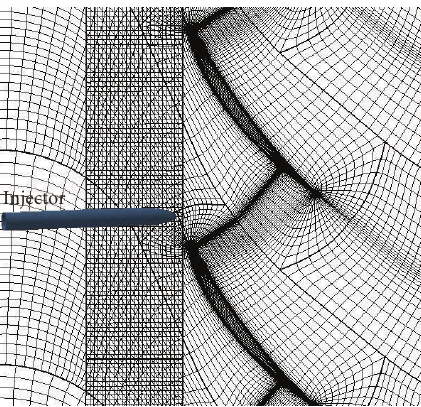
Figure 2: Circumferential transducer locations. Figure 3: Computation grid on the sliding plane between injector and